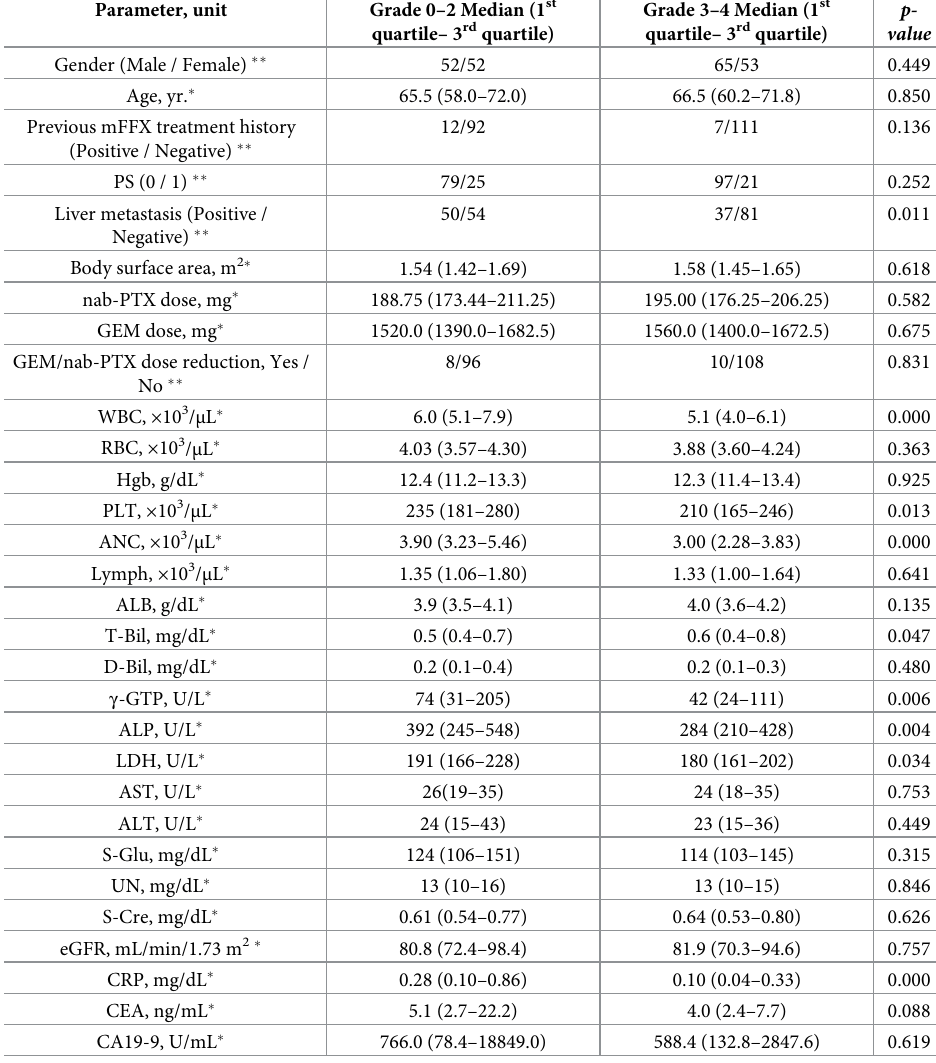
Table 2. Univariate analysis of risk factors of neutropenia Grade 3/4 in patients receiving GnP therapy. Parameter,